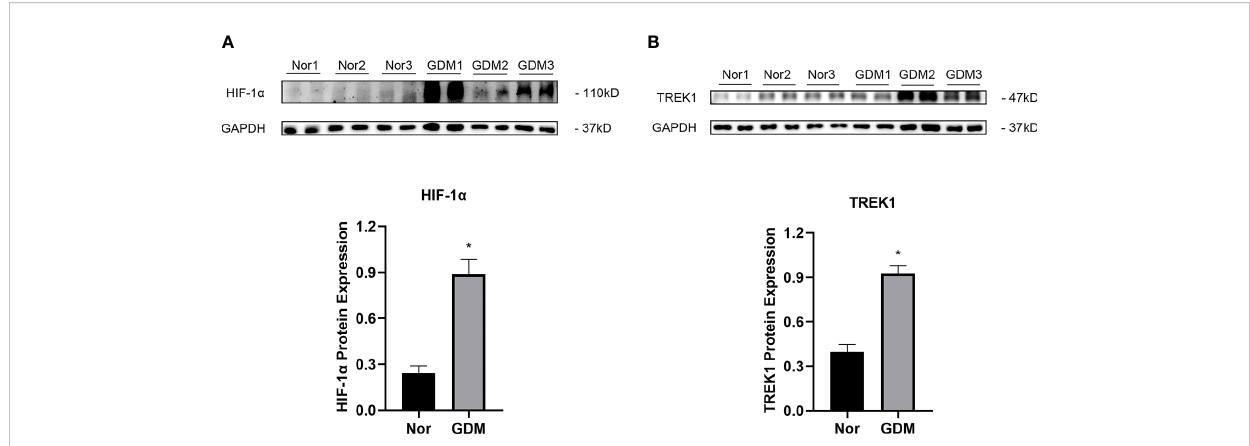
FIGURE 2 Expression of HIF-1 a and TREK1 protein increased in the uterine tissues of patients with GDM. Uterine tissues from normal (Nor) individuals and patients with GDM. The total protein of each group was extracted, and HIF-1 a (A) and TREK1 (B) protein expression was measured by western blot analysis. Data are presented as means ± SEM, n = 6 to 7. * means GDM vs, Nor and P<0.05. GDM, gestational diabetes mellitus; HIF-1 a , hypoxia- inducible factor-1 alpha; SEM, standard error of the mean; TREK1, TWIK-1-related potassium channel.